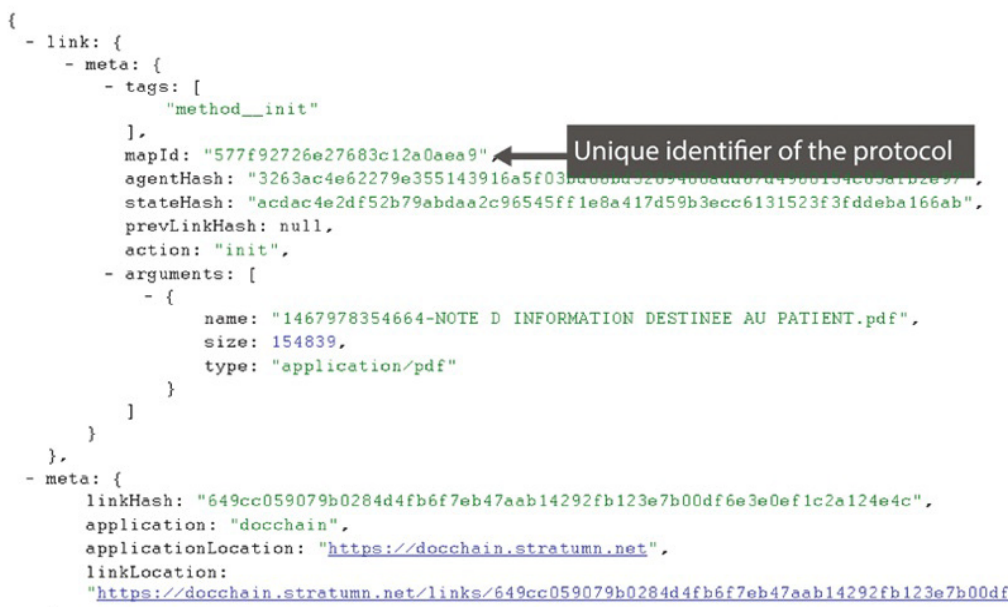
Figure 4. Consent collection master document: unique identifier